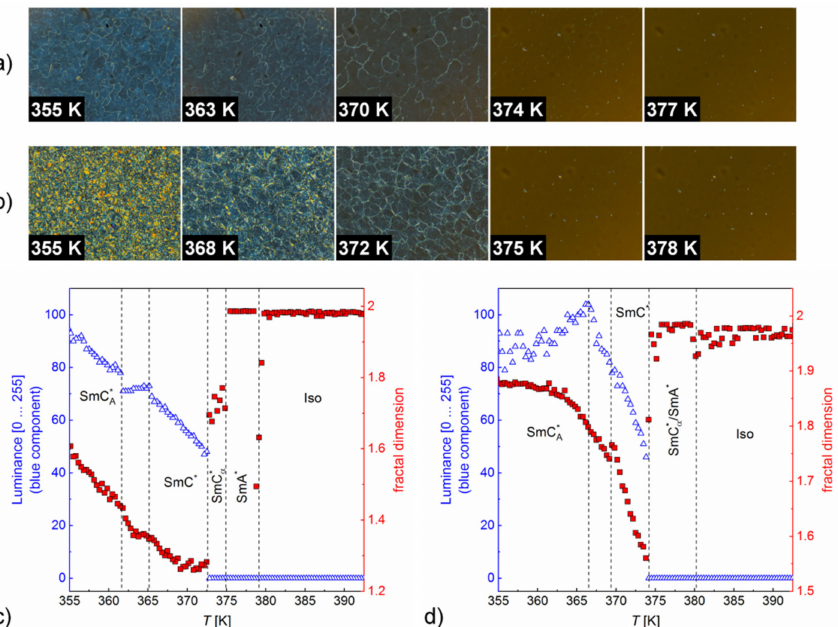
Figure 4. POM textures of 3F7FPhH6 collected during cooling ( a ) and heating ( b ) with the 2 K/min rate and the corresponding results of the numerical analysis for cooling ( c ) and heating ( d